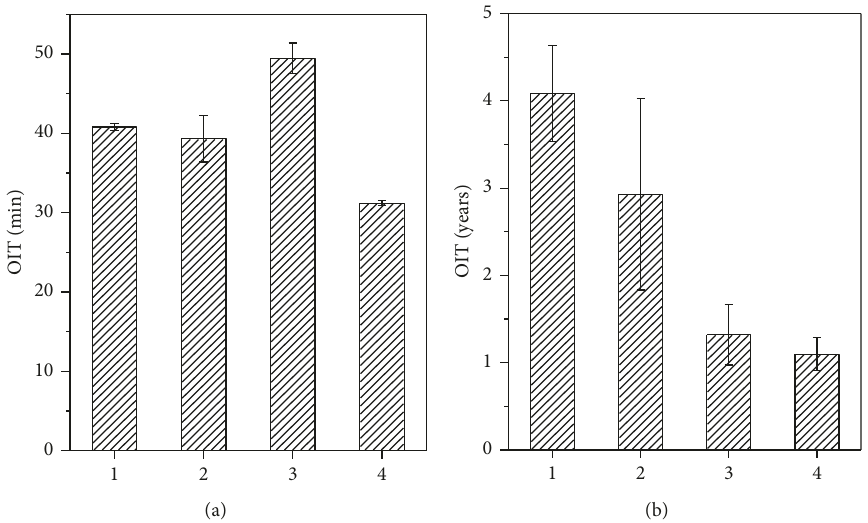
Figure 3: OITs for olive oils: (1) C+A, (2) Ma, (3) Ko, and (4) Ar predicted from nonisothermal experiments using equation (3). (a) 150 ° C. (b) 50 ° C.